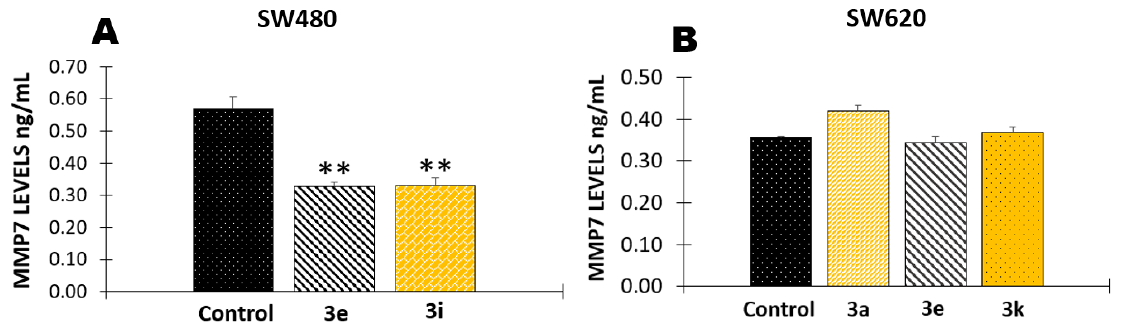
Figure 8. Concentration of matrix metalloproteinase 7 (MMP7) on SW480 ( A ) and SW620 cells ( B ). Data are presented as the mean ± SE of two independent experiments (** p < 0.01).